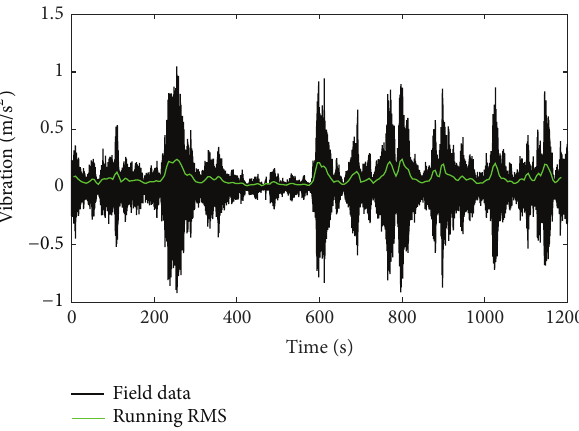
Figure 3: Field data and the running RMS.